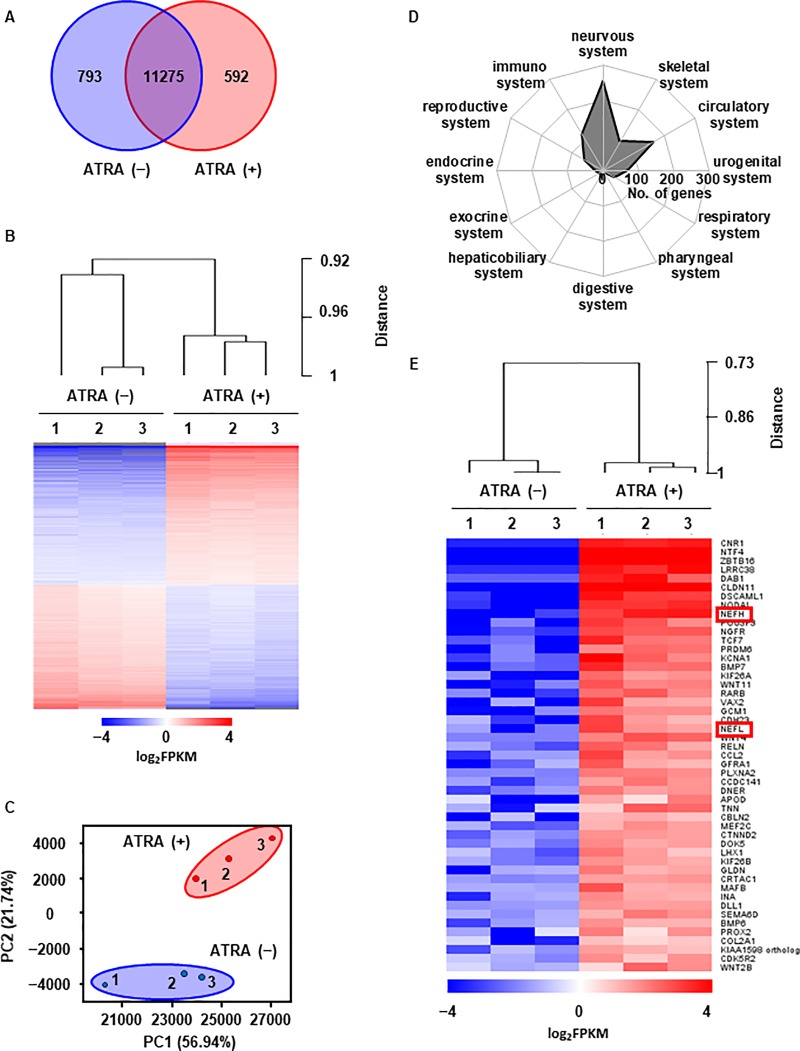
The effect of ATRA on gene expression profiling of DFATs.(A) Differentially expressed genes in canine DFATs treated with or without ATRA. (B) Hierarchical clustering and heat map of differentially expressed genes (P < 0.05) based on the RNA-seq data. The number above the heatmap indicates independent biological replicates. Red and blue indicate up-regulated and down-regulated genes, respectively. (C) Principle component analysis of samples from canine DFAT treated with or without ATRA (D) Radar chart showing the number of differentially expressed genes (P < 0.05) under GO terms related to the nervous system, skeletal system, circulatory system, urogenital system, respiratory system, pharyngeal system, digestive system, hepaticobiliary system, exocrine system, endocrine system, reproductive system and immune system in canine DFAT treated with or without ATRA. (E) Hierarchical clustering and heatmap illustrating the expression of the top 50 nervous system development genes in ATRA-treated DFATs. The number above the heatmap indicates independent biological replicates. Red and blue indicate up-regulated and down-regulated genes, respectively.